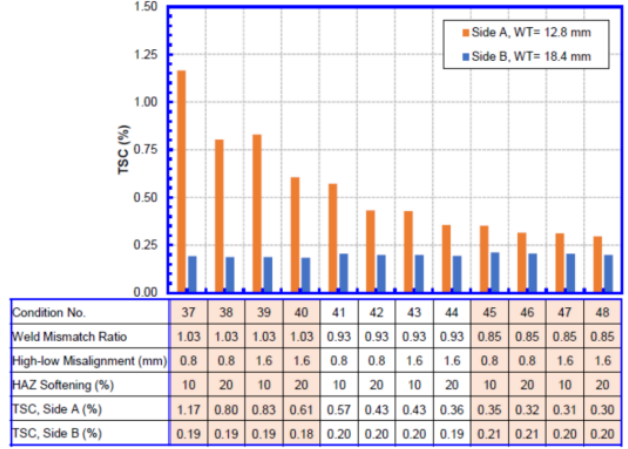
Figure 11. Average TSC of girth welds with 12.8 mm + 18.4 mm WT.